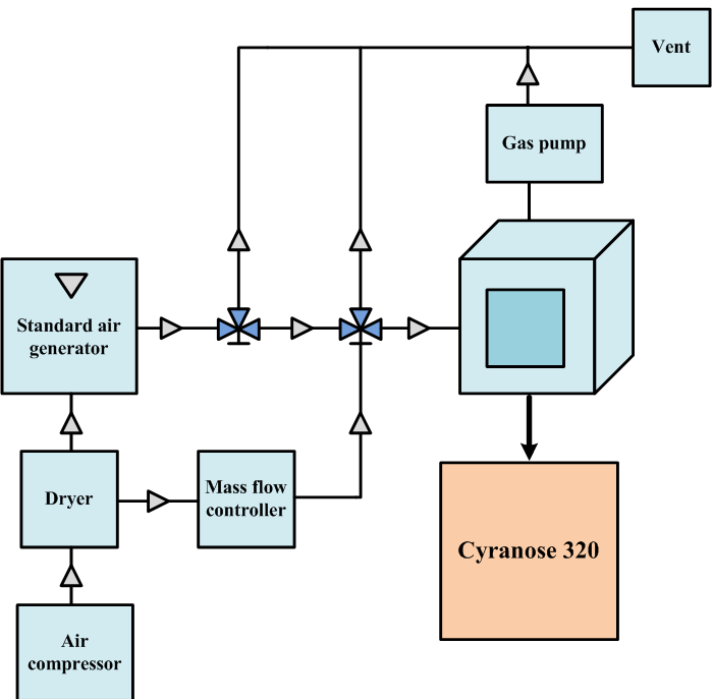
Figure 2. A schematic plot of the experimental setup for data collection.